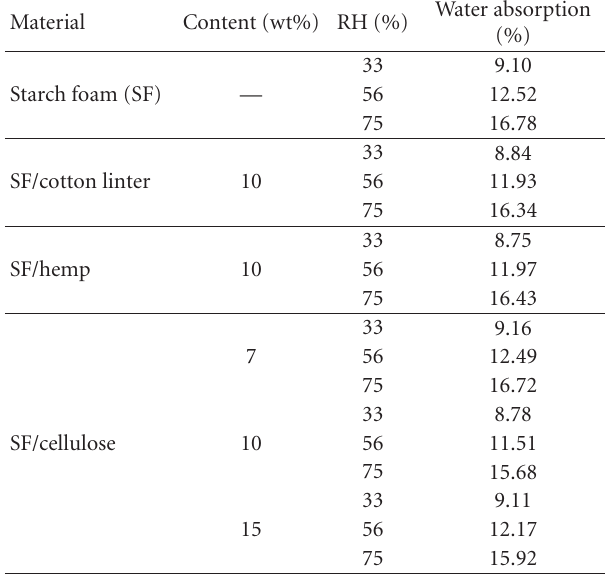
Table 9: Water absorption contents of starch-based biocomposites foams compared to starch foam.